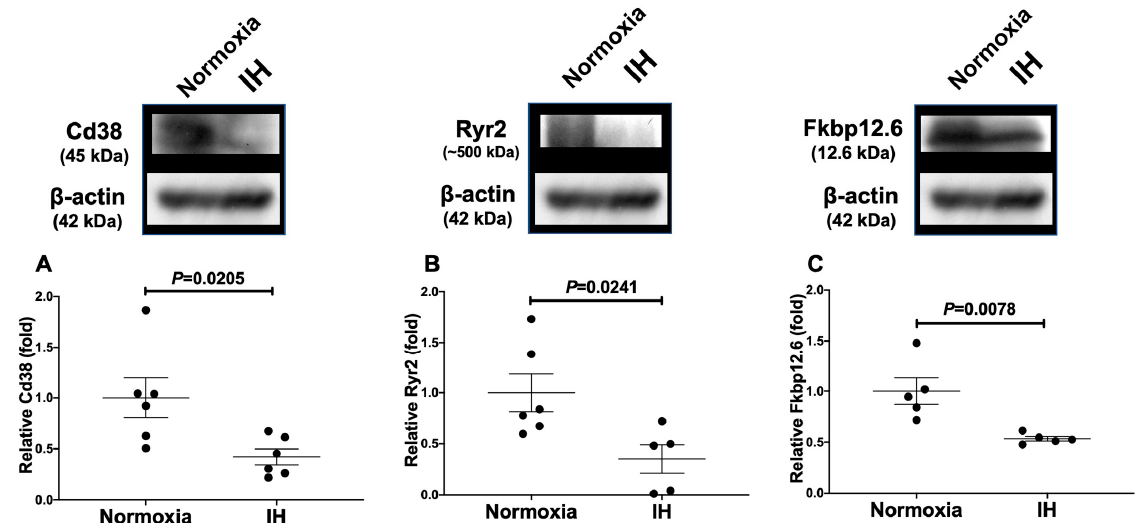
Figure 3. Relative protein expression levels of ( A ) Cd38, ( B ) Ryr2, and ( C ) Fkbp12.6 in rat H9c2 cardiomyocytes subjected to IH. The Cd38, Ryr2, and Fkbp12.6 band densities were quantified through image analysis and then normalized to β‐ actin, as measured in the same blot. Each bar represents the mean of six independent measurements. The relative expression levels of the Cd38, Ryr2, and Fkbp12.6 are arbitrarily presented. The protein level exposed to normoxia was set to 1.0. The results are expressed as the mean ± SE in arbitrary units. A representative immunoblot with the apparent molecular weight is shown in the upper panel.